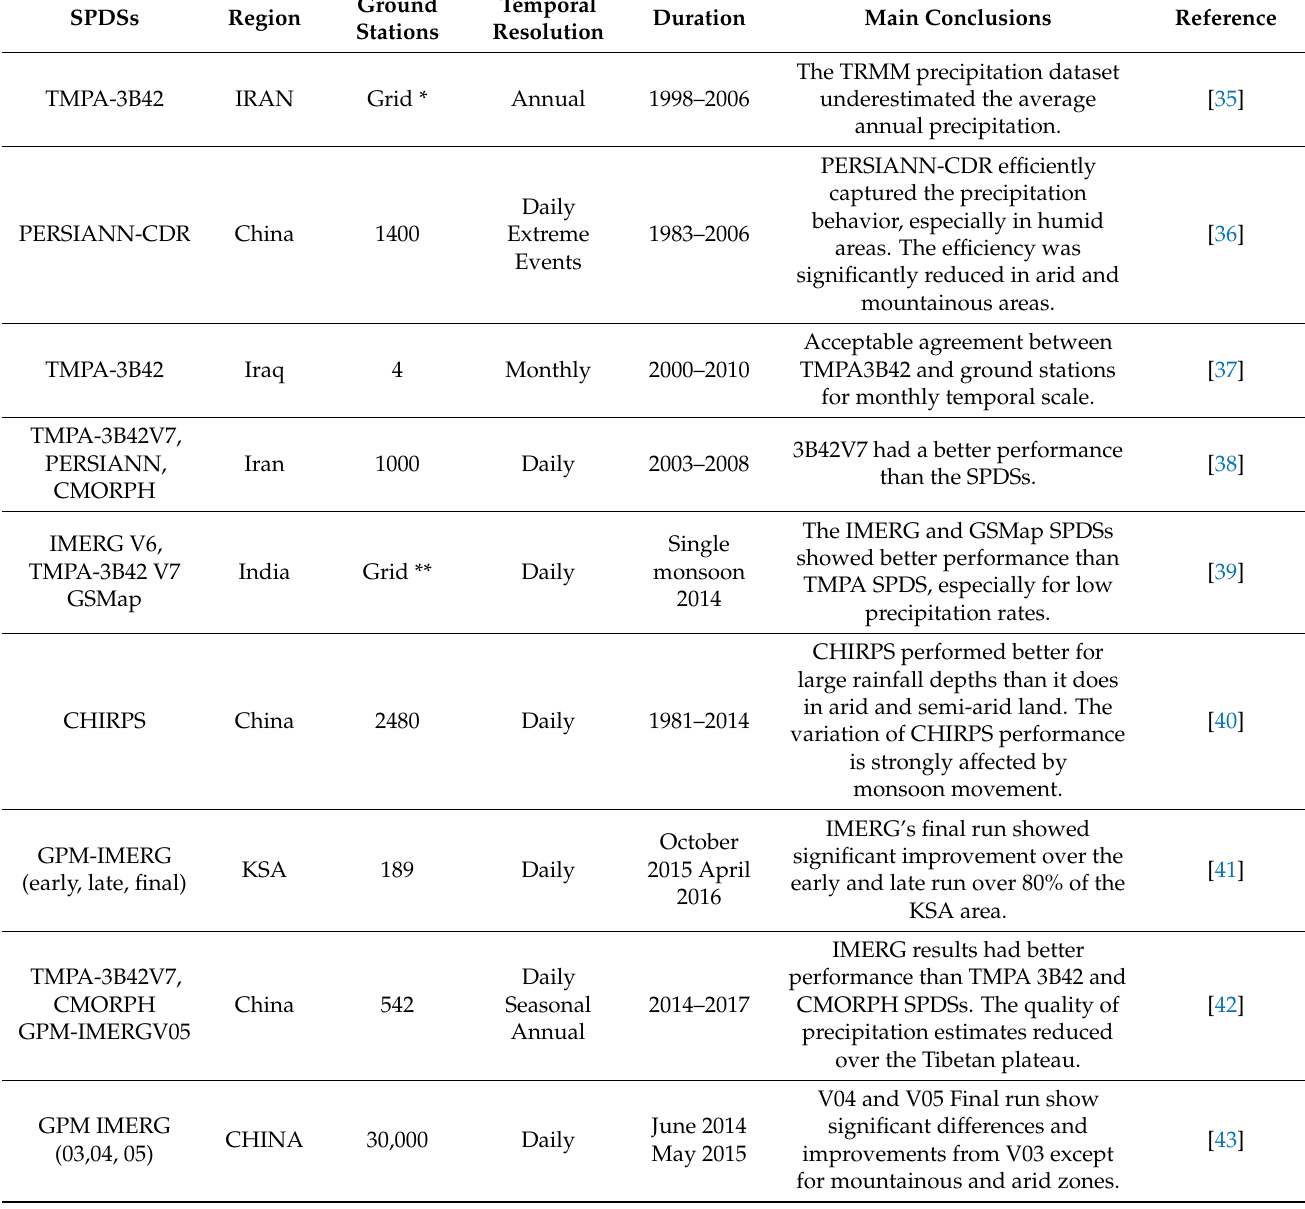
Table 3. Review of SPDSs assessment studies based on rain gauges’ measurements